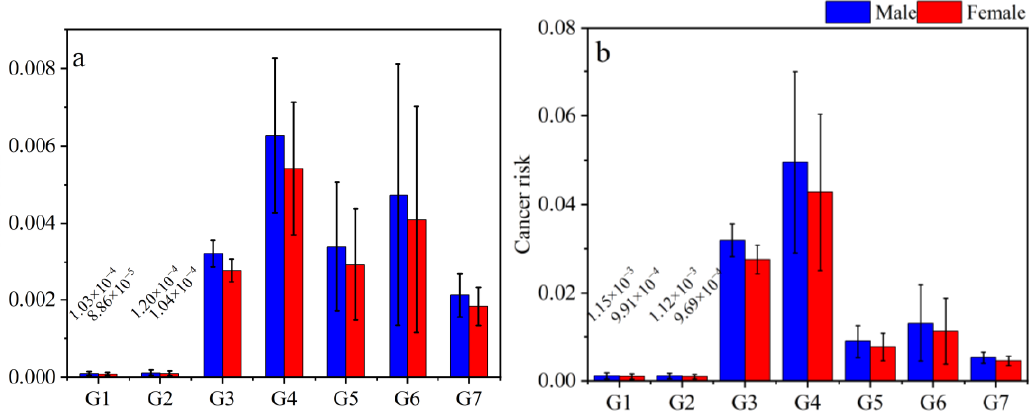
Figure 4. Cancer risks estimated from indoor gas and particulate phases PAHs exposures (( a ) refers to gas phase, ( b ) refers to particulate phase).